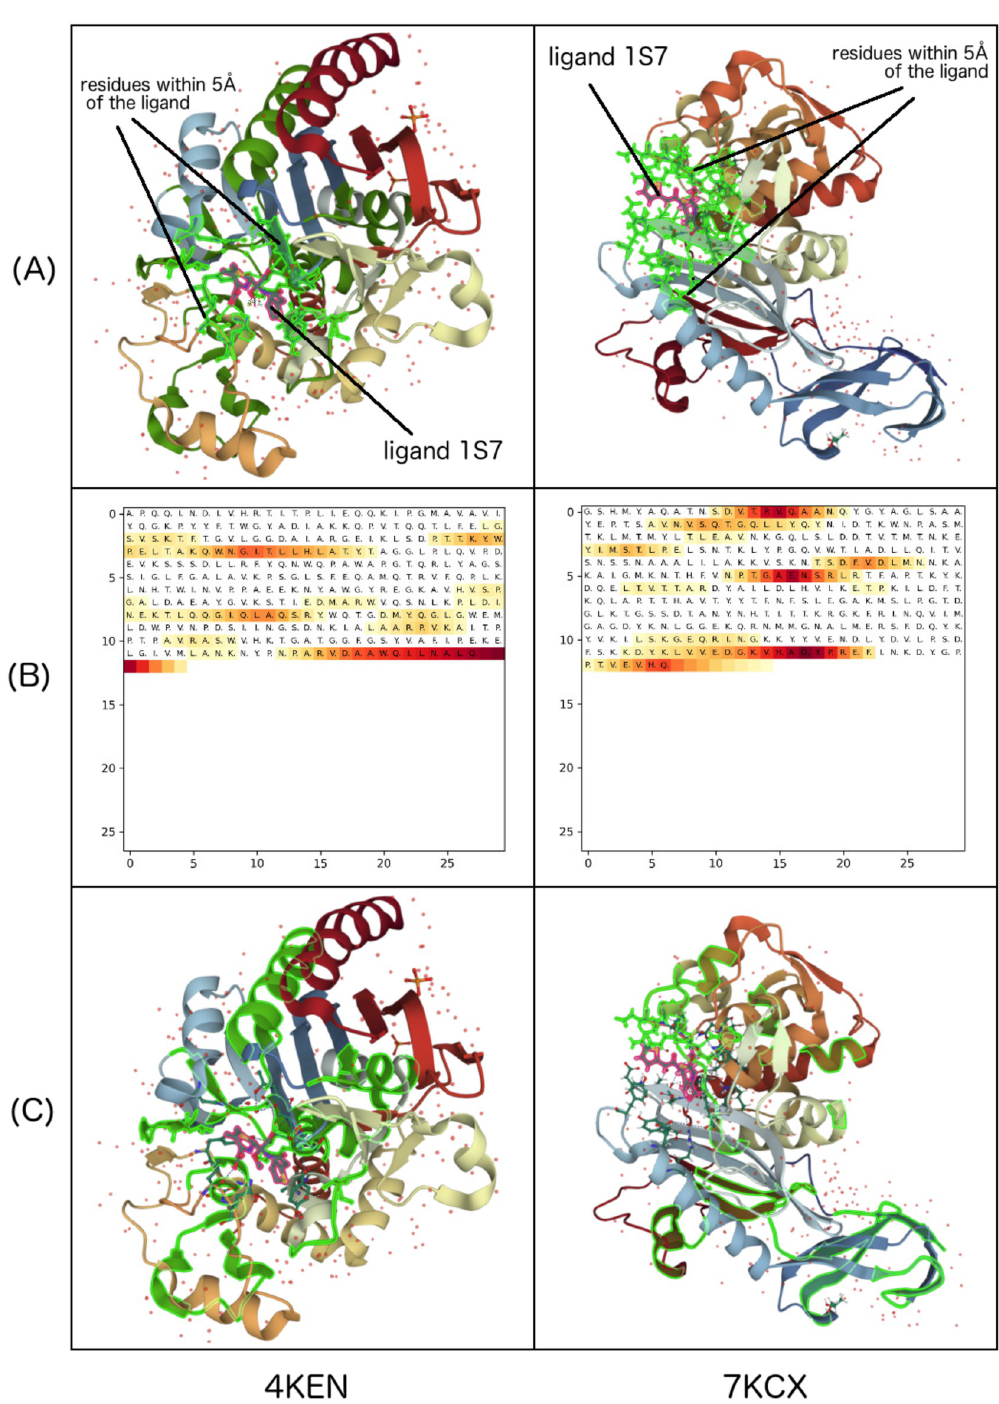
Fig 10. Examples of using Grad-CAM to explain the CPI prediction given by our model. The examples include the CPIs between the ligand 1S7 and two different proteins, AmpC beta-lactamase in Escherichia coli K-12 (PDB ID 4KEN) and Penicillin-binding protein 4 (PDB ID 7KCX): (A) structure retrieved from PDB; (B) Grad-CAM explanation in heat map; and (C) Grad-CAM explanation in 3D view.